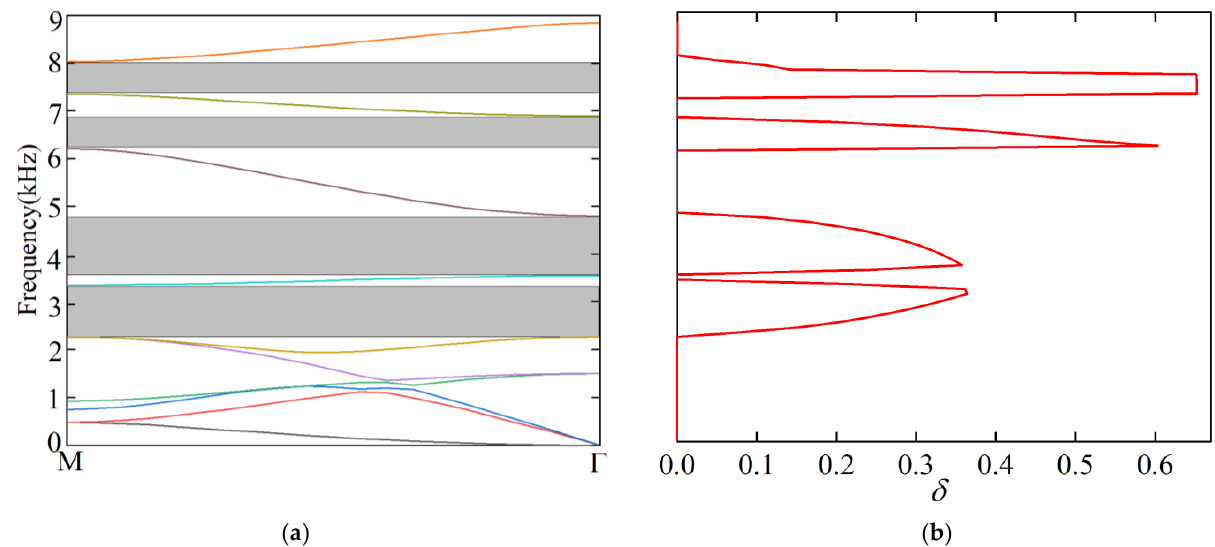
14 of 23 Figure 9. Transmission loss of the finite length piezoelectric phononic crystal.